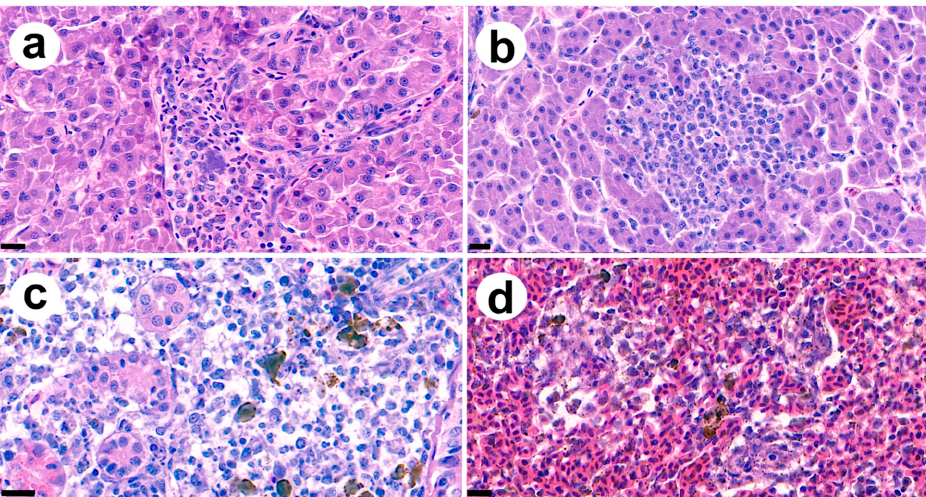
Figure 4. ( a ) Bacteremia observed on the hepatic vein of infected fish (bar indicating 20 μ m) and vacuolation can be observed on surrounding hepatocyte. ( b ) Moderate focal to coalescing hepatic necrosis was observed on the liver of infected fish (bar indicating 20 μ m). ( c ) Hyaline droplets accumulated on renal tubule epithelial cells with macrophages and melanocytes observed around the damaged tubule (bar indicating 20 μ m). ( d ) Coagulative necrosis was observed in spleen with a large amount of cellular debris accompanied by free bacterial rods and macrophages surrounding the area (bar indicating 10 μ